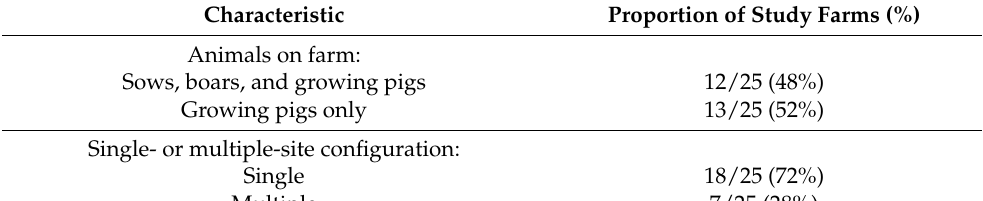
Table A2. Cont. Characteristic Proportion of Study Farms (%) Animals on farm: Sows, boars, and growing pigs 12/25 (48%) Growing pigs only 13/25 (52%) Single- or multiple-site configuration: Single 18/25 (72%) Multiple 7/25 (28%) Weaner pig buildings described in questionnaire: Type: Conventional with solid/slatted/mesh-floored pens 24/40 (60%) Eco-shelters with straw-floor pens Age of buildings: